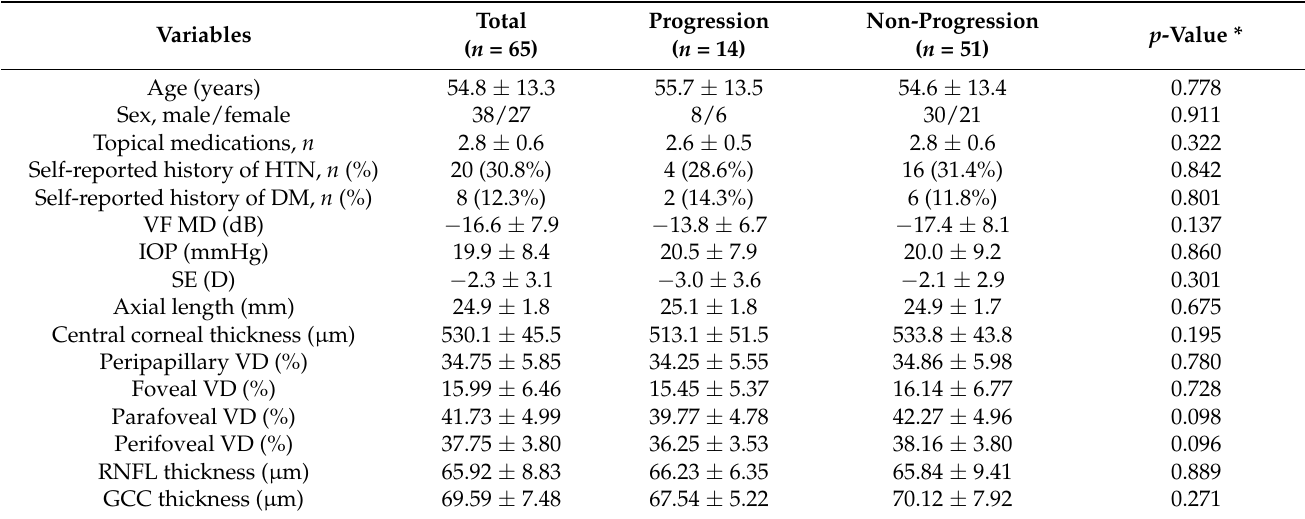
Table 1. Baseline demographics and the clinical characteristics of the VF progression and non-progression